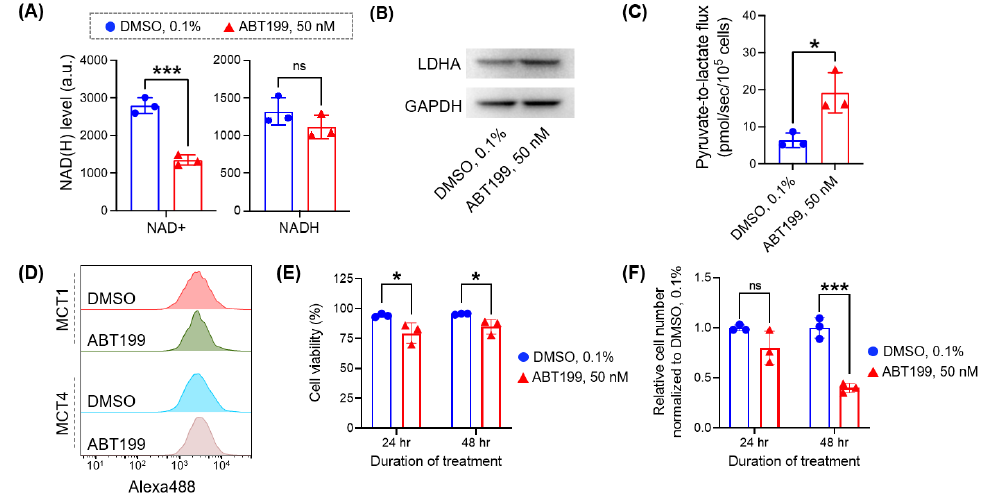
Figure 4. Micro-slab MR coil with HP [1- 13 C] pyruvate enables simultaneous assessment of metabolic flux in cancer cells with different doses of drug treatment. ( A ) Levels of NAD + and NADH in MOLM13 cells after 24-h treatment of ABT199 (mean ± SD, n = 3 biological replicate). ( B ) The expression levels of LDHA in MOLM13 cells after 24-h treatment of ABT199. Original Western blot images are provided in Supplementary Figure S3. ( C ) Pyruvate-to-lactate flux in MOLM13 cells after 24-h treatment of ABT199. It was measured with the micro-slab MR coil using hyperpolarized [1- 13 C] pyruvate. ( D ) The expression levels of MCT1 and MCT4 in MOLM13 cells after 24-h treatment of ABT199. ( E , F ) Cell number ( E ) and viability ( F ) of MOLM13 cells with ABT199 treatment (mean ± SD, n = 3 biological replicate). Statistical analyses were conducted with unpaired two-tailed t test: ns (not significant) p > 0.05, * p < 0.05, *** p < 0.001.